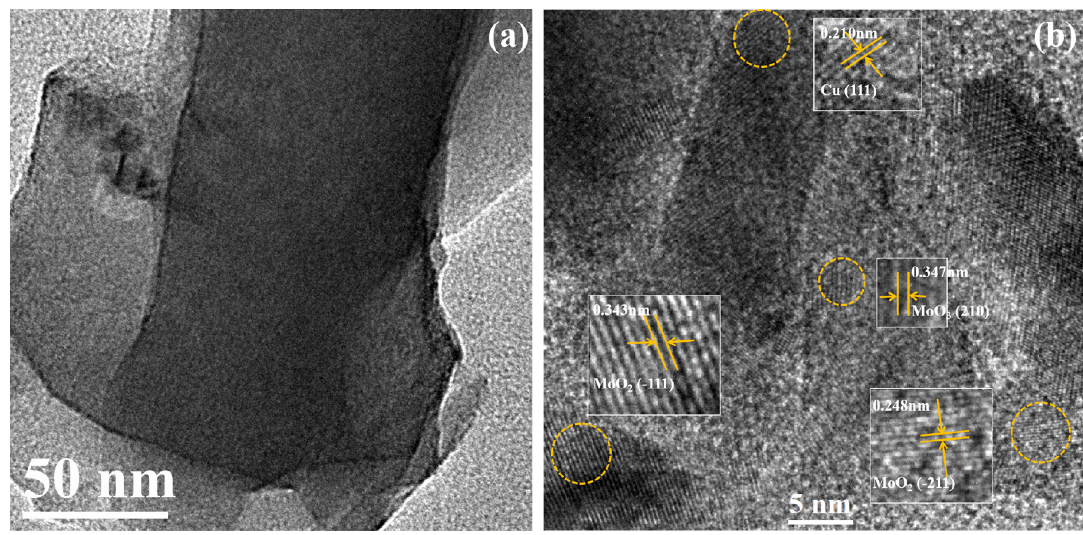
Figure 3. The TEM ( a ) and HRTEM ( b ) images of Cu/MoO x (1:1) catalyst